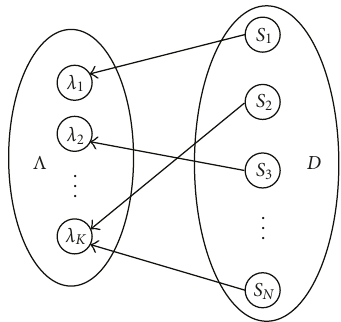
Figure 3: Bipartite graph of exemplars ( x ) and